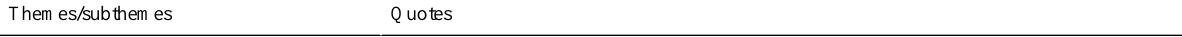
Table 2. Themes and subthemes on positive aspects of portal use with exemplar